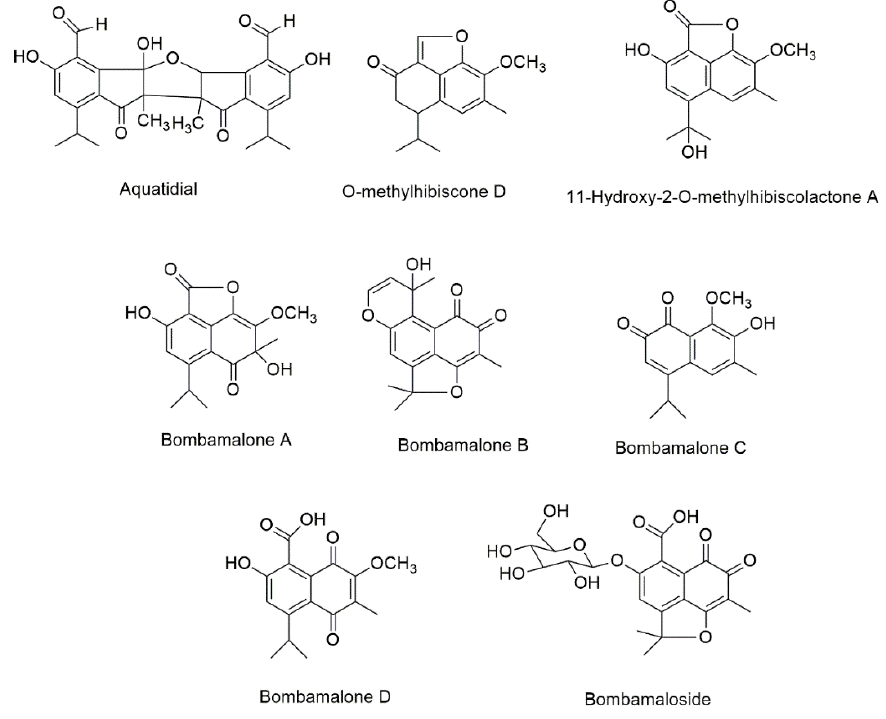
Figure 4. The chemical structures of new isolated compounds from Bombacoideae species.